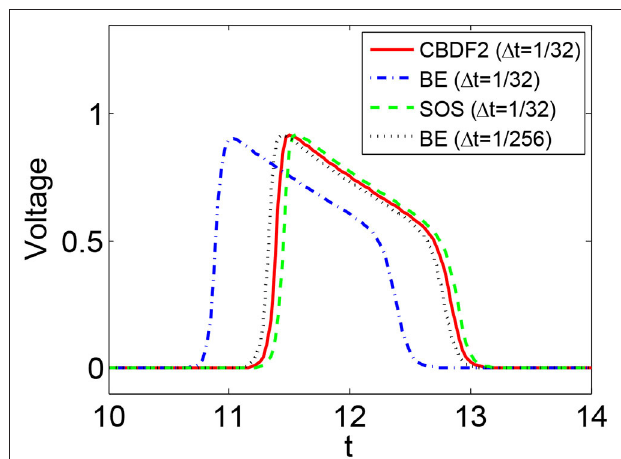
FIGURE 1 | The membrane voltage trajectories obtained from different methods with timestep size 1 t precision solution is obtained from the BE method with a small timestep size 1 t 1 / 256 and spatial size h =